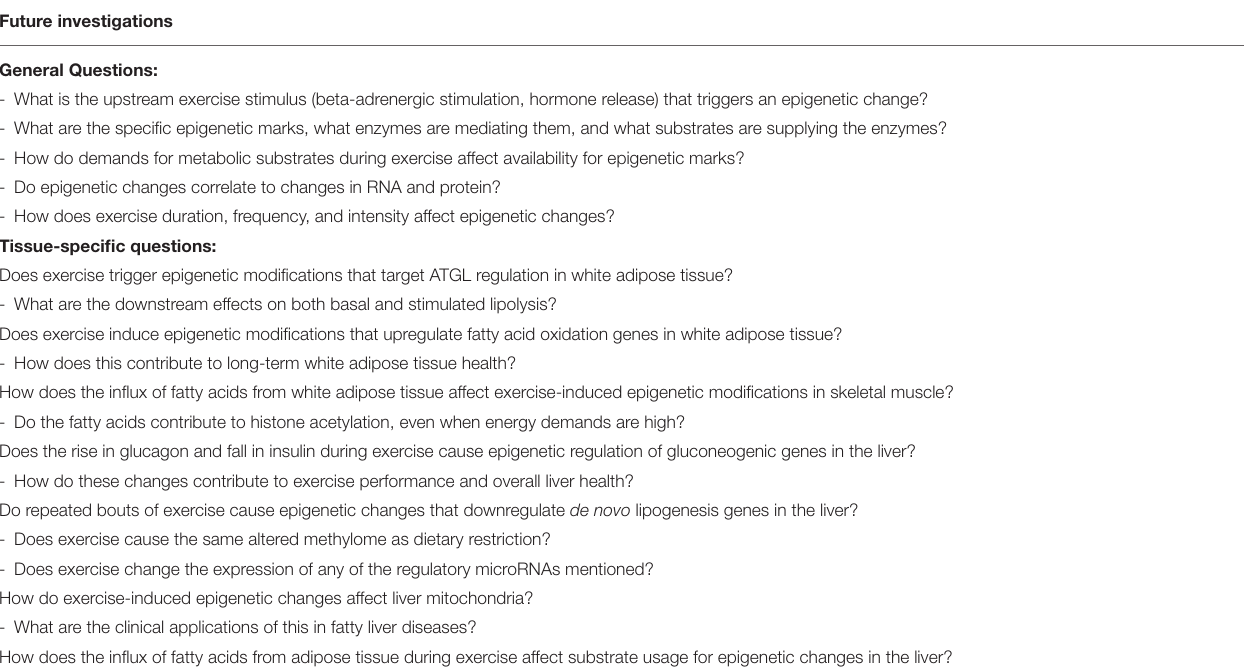
TABLE 2 | Areas of future investigation to examine metabolism-related exercise-induced epigenetic